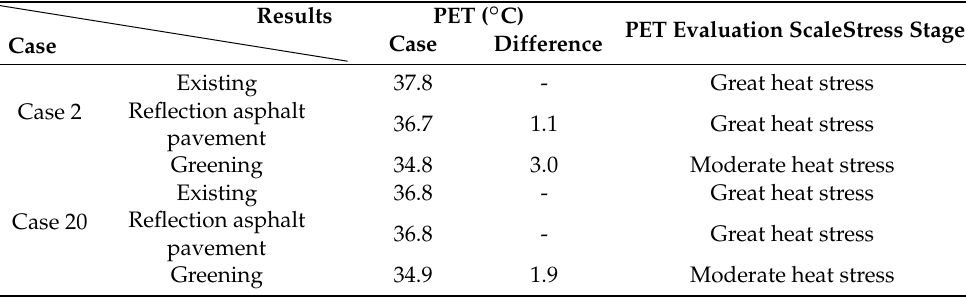
Table 9. Results of applying the heat island mitigation plan.